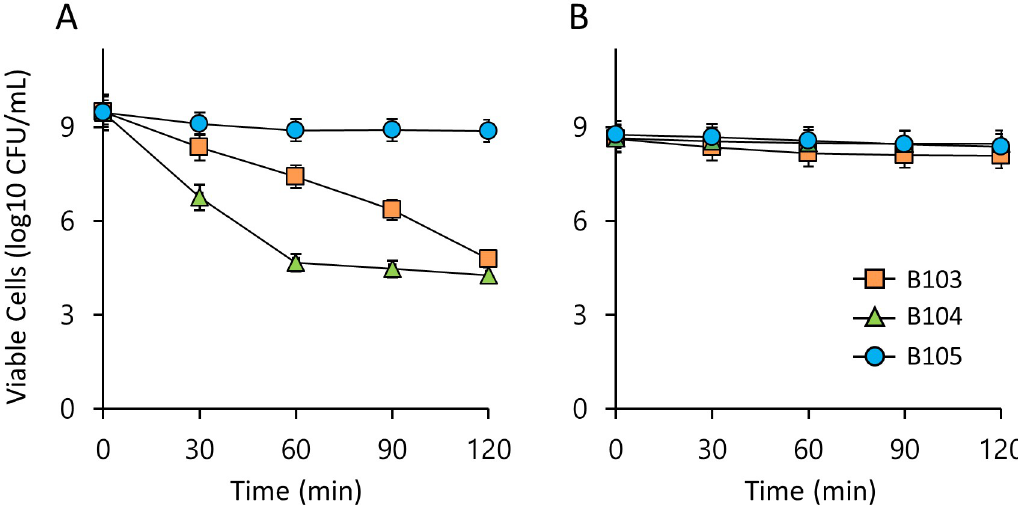
Fig 3. Survival of LAB in simulated gastric juice of humans. Viable cells of LAB over time in MRS broth containing 1% pepsin at pH 2.2 (A) or pH 2.5 (B). Values are means of data from triplicate experiments, with the standard deviation (SD) indicated by vertical